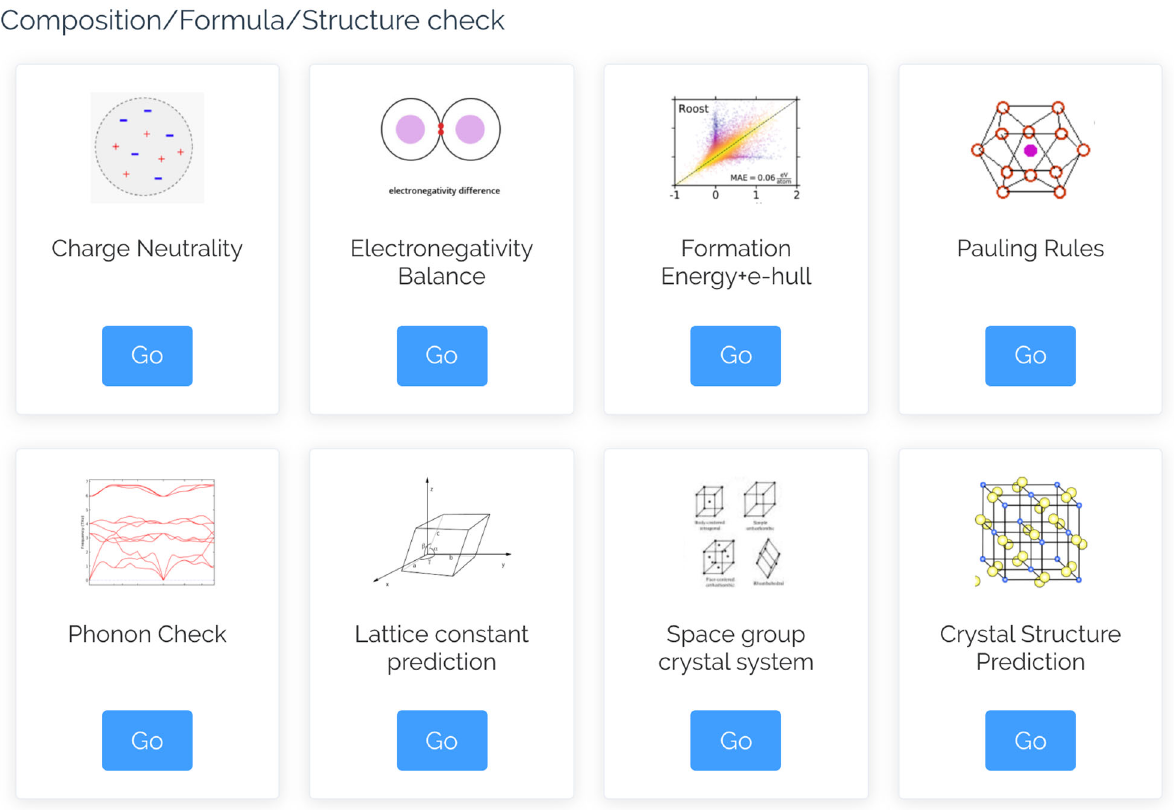
Fig. 1 Tools for composition and structure validation and